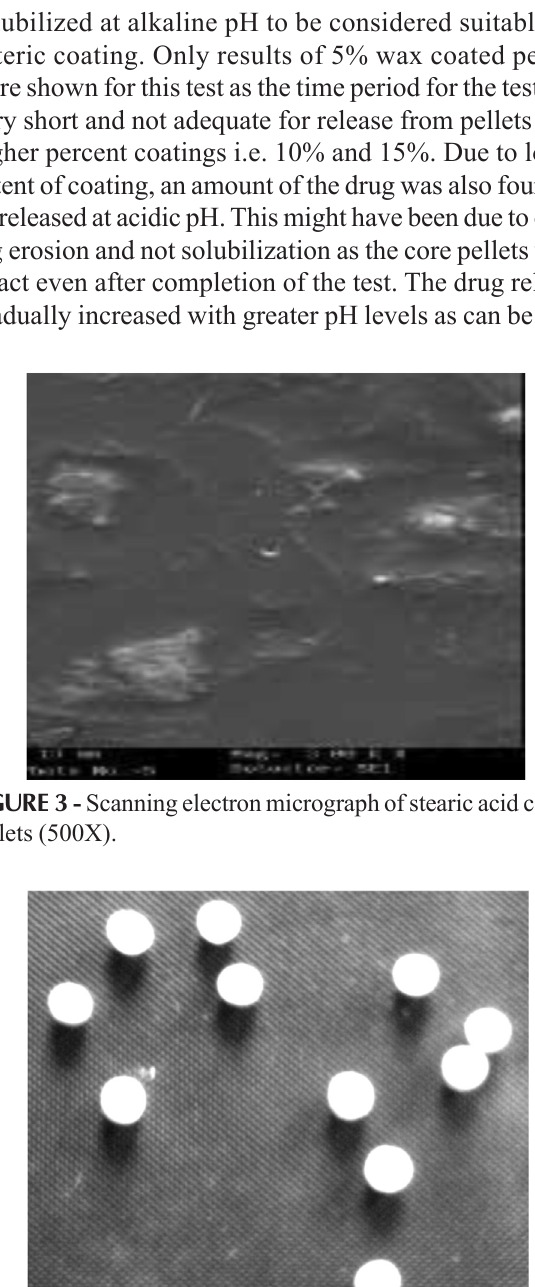
FIGURE 2 - Scanning electron micrograph of stearic acid coated pellets (30X). FIGURE 4 - Photograph of palmitic acid coated pellets.